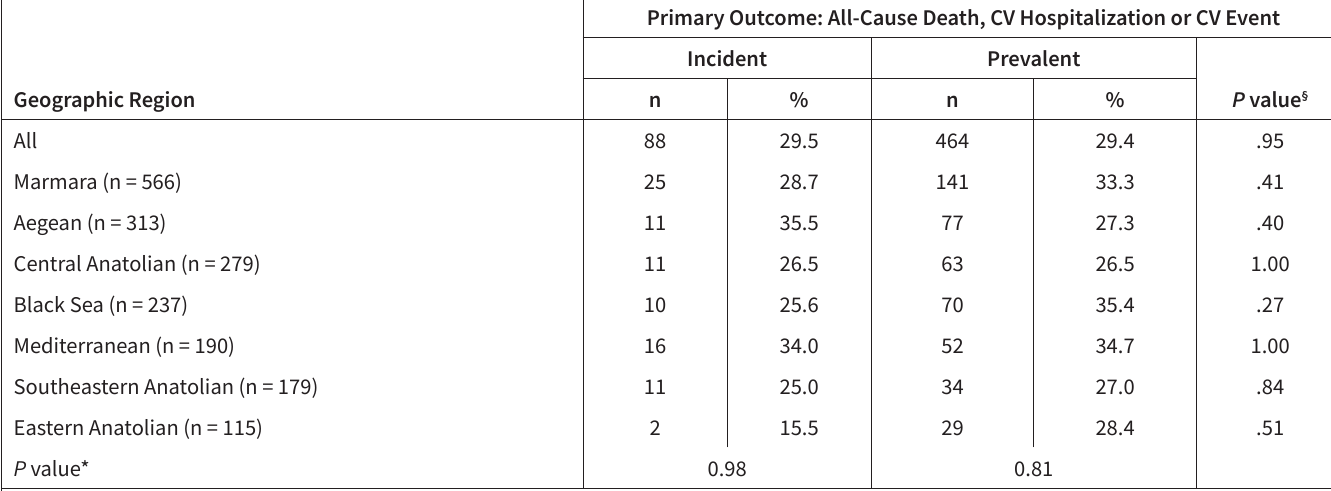
the patterns in these groups were preserved in geographic Table 2. The Rate of the Primary Outcome Across Different Regions strata, the highest and lowest increments from baseline were observed in the Aegean (17.8%) and Eastern Anatolian (5.8%) regions, respectively. The mean Hb levels over time usually exhibited a consistent pattern when analyzed by gender, age Geographic Region group, and dialysis indication except a small increment in the incident patients till visit 4 compared to baseline. Male patients had significantly higher mean Hb levels compared to their female counterparts at all time points (Figure 2A), whereas the age group did not significantly affect Hb levels (Figure 2B). The significant difference between the patients with incident versus prevalent disease regarding Hb levels was lost by visit 4 and pre- served till the end of the study (Figure 2C). The percentage of patients who were under target Hb levels ( < 10 g/dL) constituted 20.4% of the population at baseline and this was decreased to 13.7% at visit 8 with a relative reduction .82 of 32.8% overall. While all regions showed varying degrees of decrease, the highest and lowest reduction in the patients who were below the targeted Hb levels were recorded in the Eastern Table 3. The Rate of the Primary Outcome Across Different Regions Stratified by Incident or Prevalent Condition Primary Outcome: All-Cause Death, CV Hospitalization or CV Event Incident Geographic Region